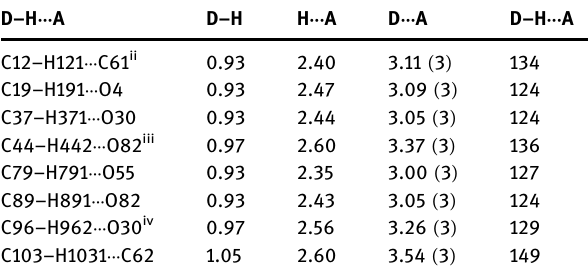
Table 5: Hydrogen - bond geometry ( Å and ° ) of complex